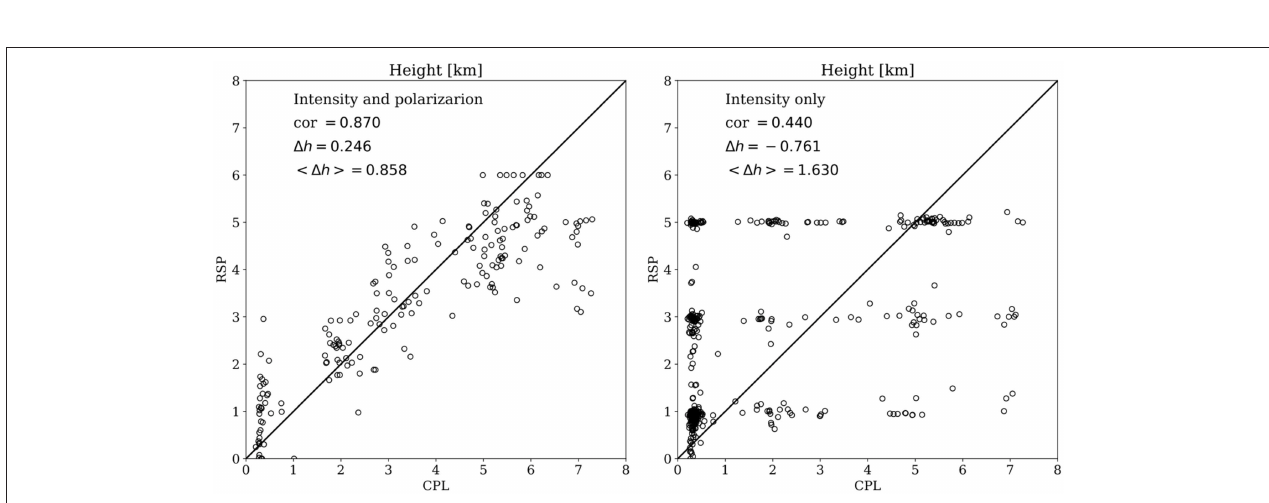
FIGURE 9 | Retrieved aerosol layer height from the Research Scanning Polarimeter (RSP) vs. the same derived from the Cloud Physics Lidar (CPL) using both radiance and polarization measurements (left) , and using only radiance measurements (right) . Measurements were obtained during the Polarimeter Definition Experiment (PODEX) and the Studies of Emissions, Atmospheric Composition, Clouds and Climate Coupling by Regional Surveys (SEAC4RS) measurement campaigns. Adapted with permission from Wu et al. (2016), John Wiley & Sons.